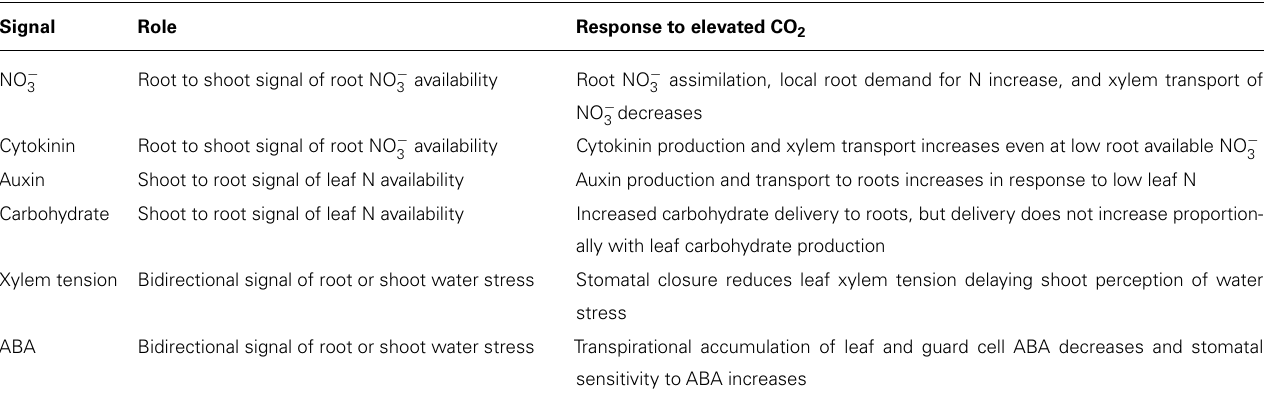
Table 1 | Root–shoot N and water signal responses to elevated CO 2